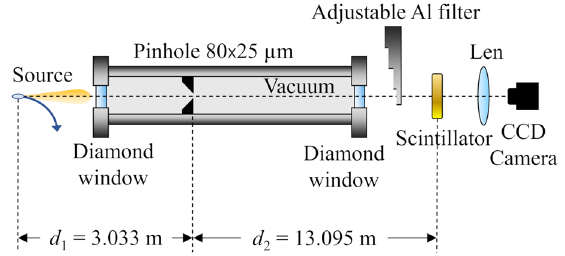
FIG. 5. A simplified diagram of the x-ray pinhole-camera diagnostic beamline at NSLS-II.